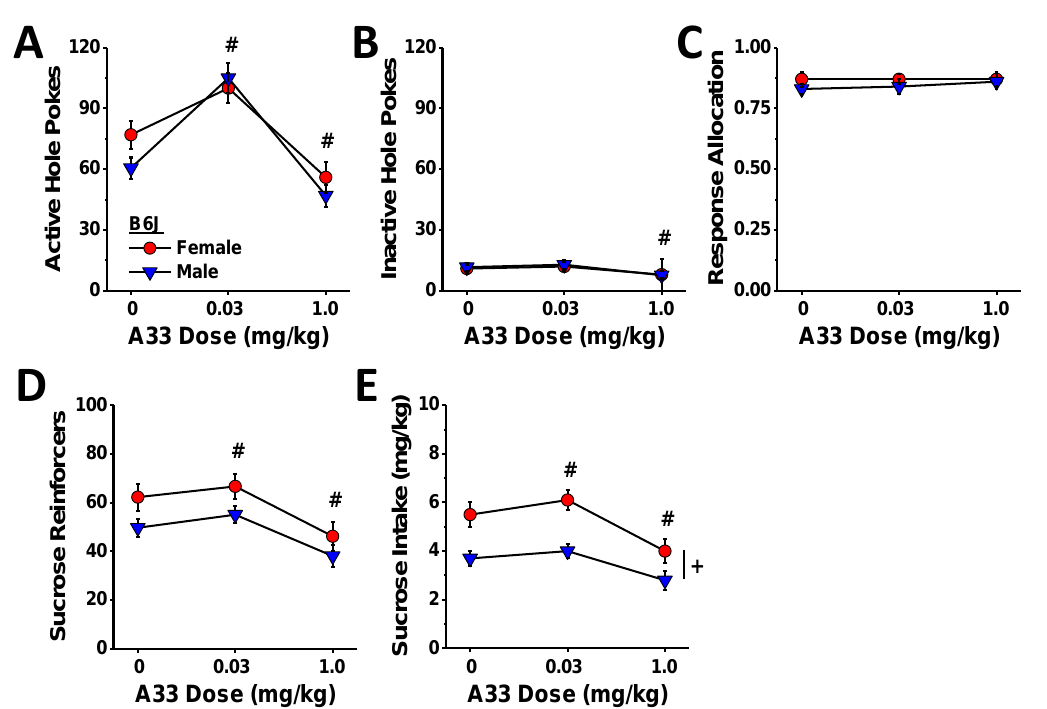
Figure 8. Summary of the effects of A33 pretreatment on established sucrose self-administration for a 10% sucrose reinforcer in B6J mice, highlighting a biphasic effect of A33 pretreatment on the number of nose pokes into the active, sucrose-reinforced hole ( A ), the number of reinforcers earned ( D ), and sucrose intake ( E ) by both female and male mice. Only the 1.0 mg/kg A33 dose reduced the number of nose pokes into the inactive, non-reinforced hole ( B ), and neither dose affected the allocation of responses across the two holes ( C ). The data represent the mean ± SEM of 11 mice/sex. + represents a significant sex effect, p < 0.05; # p < 0.05 vs. 0 mg/kg A33 for both sexes.